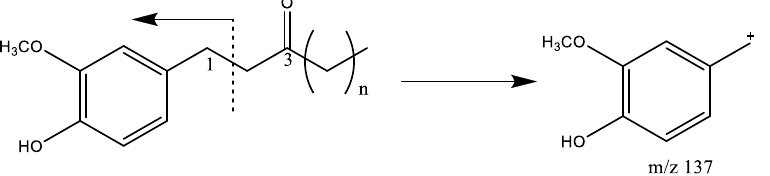
Figure 2. Fragmentation pathway for paradol compounds 4 ( n = 6), 9 ( n = 7), 13 ( n = 8), 22 ( n = 10). The second group correspond to gingerols, which are the most known pungent compounds of ginger [25], and includes peaks 1 (Rt = 8.20 min), 3 (Rt = 12.93 min), 10 (Rt = 18.23 min), 23 (Rt = 23.52 min) and 30 (Rt = 28.43 min). Peak 1, with a [M+Na] + ion at m/z 289.1512 (C 15 H 22 O 4 Na), was tentatively assigned to 4-gingerol. In turn, peak 3 had [M+Na] + at m/z 317.1831 (C 17 H 26 O 4 Na) and was assigned to 6-gingerol, while peak 10 with [M+Na] + at m/z 345.2137 (C 19 H 30 O 4 Na) was identified as 8-gingerol. Meanwhile, peak 23 had [M+Na] + at m/z 373.2438 (C 21 H 34 O 4 Na) and was assigned to 10-gingerol and finally, peak 30 with [M+Na] + at m/z 401.2653 (C 23 H 38 O 4 Na) was identified as 12-gingerol. All these peaks had an adduct corresponding to [M+H-H 2 O] + at m/z 249.1518, 277.1831, 305.2136, 333.2457 and 361.2740, respectively. The fragment at m/z 179 observed in gingerols (Figure 3) is produced following the path of fragmentation from dehydrated pseudomolecular ions [M+H-H 2 O] + [12]. This ion is decomposed into fragments at m/z 177, 145 and 117 by successive losses of 2 H + (2 Da), CH 3 OH (32 Da) and CO (28 Da), respectively. In turn, the formation of the fragment at m/z 177 could derive directly from the dehydrated pseudomolecular ions [M+H-H 2 O] + by the loss of CH 3 -(CH 2 ) n -CHO ( n = 2, 4, 6, 8 and 10 for 4-gingerol 6-gingerol, 8-gingerol, 10-gingerol and 12-gingerol, respectively) [11]. This ion, in turn, gives rise to the fragment at m/z 137 due to the loss of lateral chain CHCHCH 2 (40